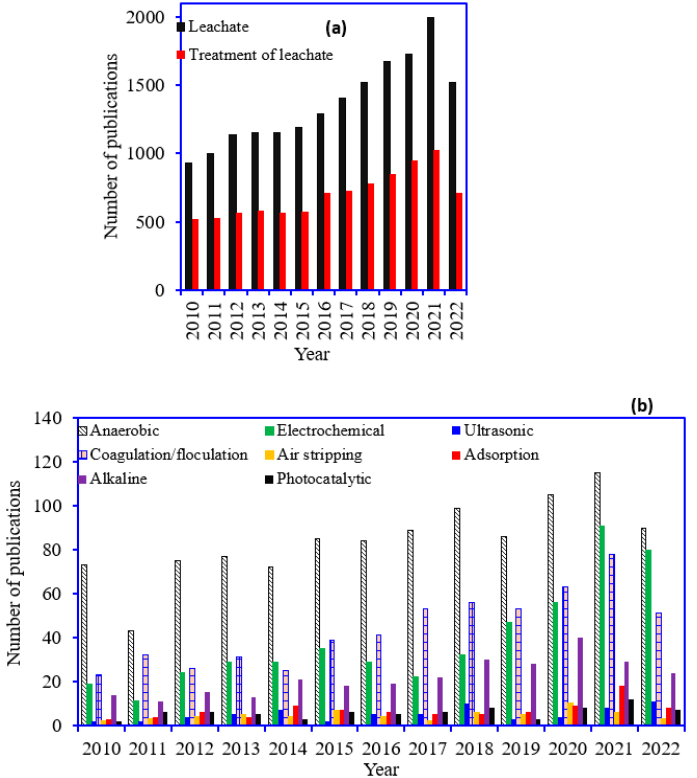
Figure 1. ( a ) Scopus database showing the number of the articles published searched using the keywords “leachate” and “treatment of leachate” and ( b ) number of the articles published searched using the keyword” treatment of leachate using various methods” between the years 2010 to September 2022.